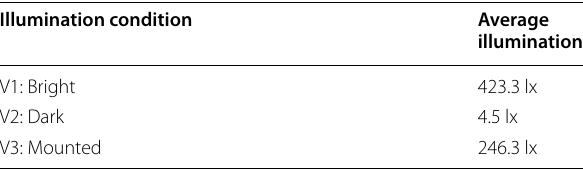
Table 10 Three concerned methods’ setup for robustness study under limited illumination